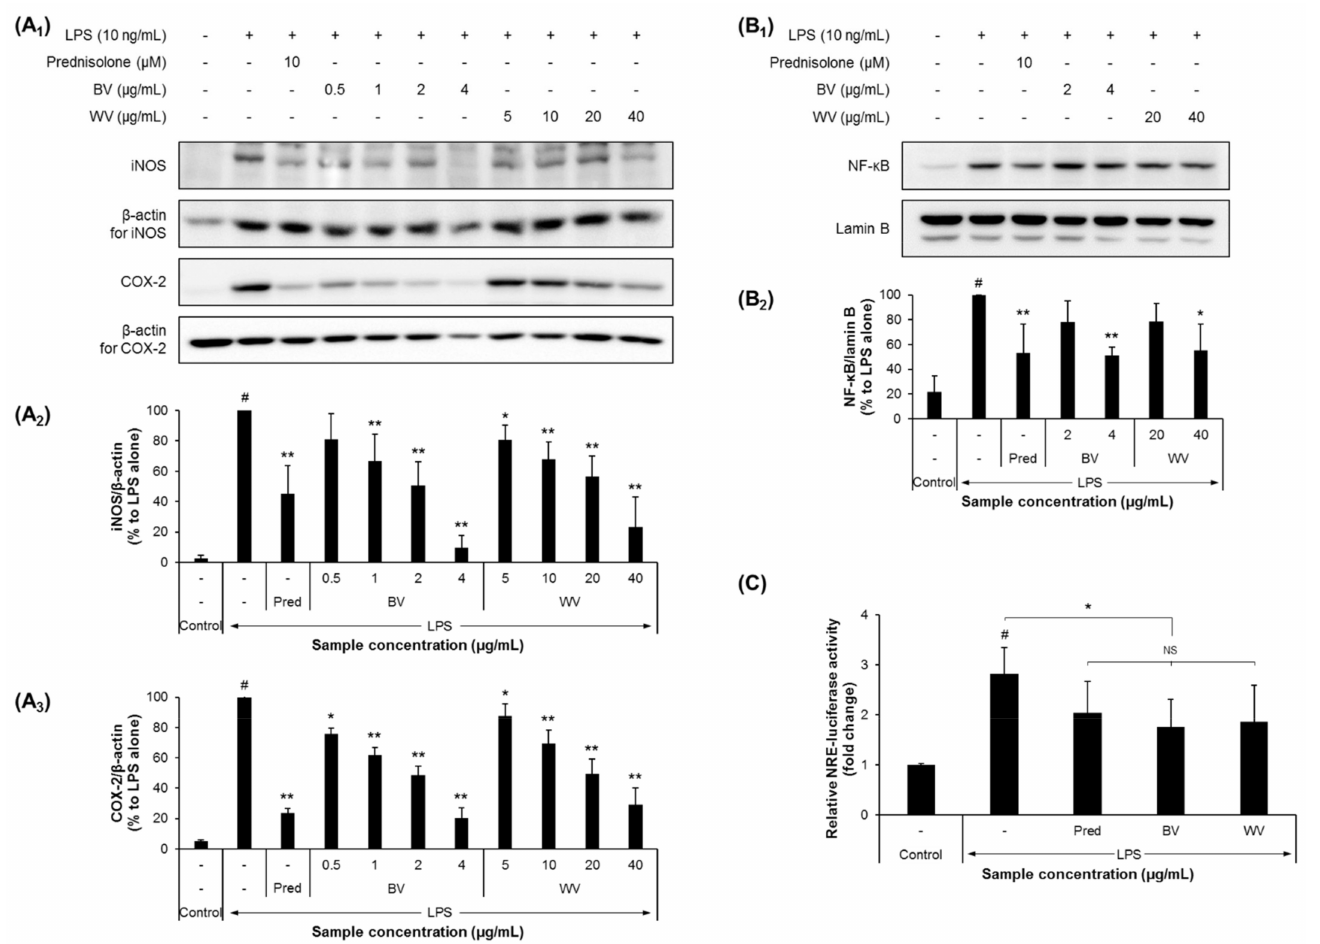
Figure 3. WV decreased the expression of inflammation-related proteins and decreased NF-kB response element (NRE) transcription activity in BV-2 cells. ( A , B ) BV-2 cells were plated in a 100-mm culture dish at a density of 2 × 10 6 cells, activated with 10 ng/mL of LPS, and treated with either WV or BV at the designated concentrations for 24 h. Prednisolone (Pred, 10 µ M) was used as the positive control. The cells were collected, lysed, and used to measure the relative expression levels of cytoplasmic iNOS and COX-2 ( A ) and nuclear NF- κ B ( B ). ( C ) BV-2-NRE cells carrying the NRE sequence linked to the luciferase reporter gene were plated into a 6-well plate at a density of 2 × 10 5 cells/well and were treated with either WV at 40 µ g/mL or BV at 4 µ g/mL for 24 h. Prednisolone (30 µ M) was used as the positive control. LPS was treated at 5 ng/mL for 6 h before the venom treatment was terminated. The cells were then collected and subjected to the measurement of the NRE-luciferase activity. N = 4 for ( A , B ) and 3 for ( C ); error bars, mean ± SD. Statistically significant differences between the means were analyzed by Student’s t -test. Hashtags ( # ) indicate a significant difference compared to the control ( p < 0.05). Asterisks (*) indicate a significant difference compared to the LPS alone treatment (*, p < 0.05; **, p < 0.01). NS, not